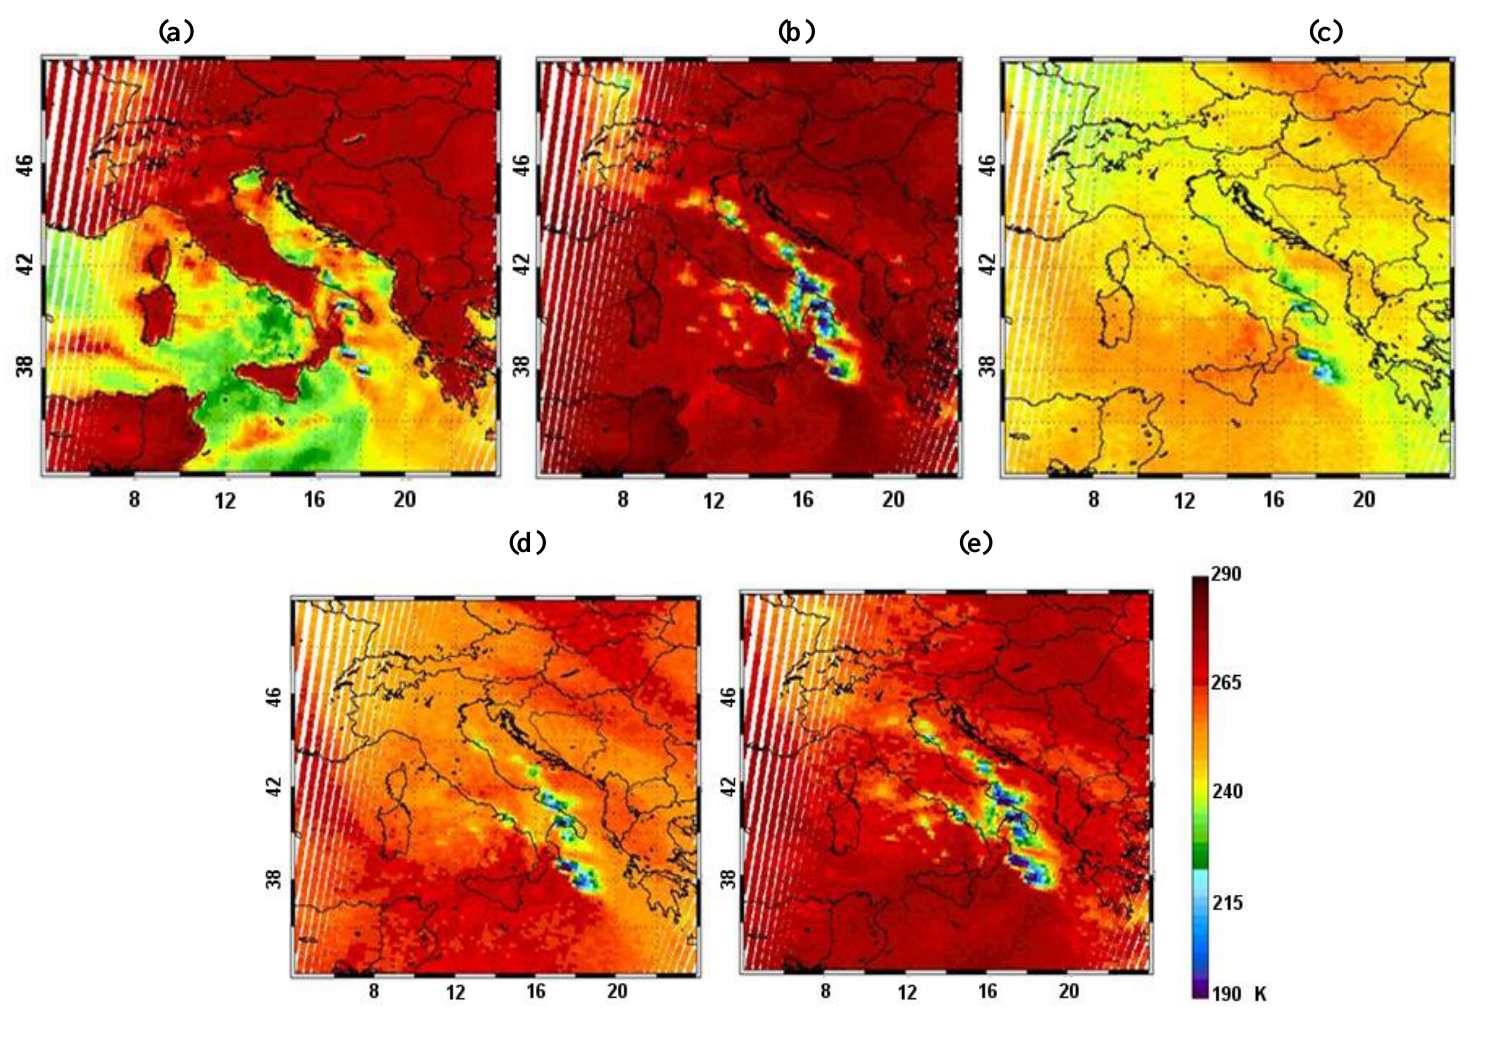
Figure 2. 26 September 2006. TBs (K) of the AMSU-B channels over Italy for a cold frontal situation. ( a ) 89 GHz, ( b ) 150 GHz, ( c ) 184 GHz, ( d ) 186 GHz and ( e ) 190 GHz. Note the increase of the values at 89 GHz over the sea and decrease over land corresponding to the cloud system, and the strong scattering at 150 GHz due to ice hydrometeors at the cloud